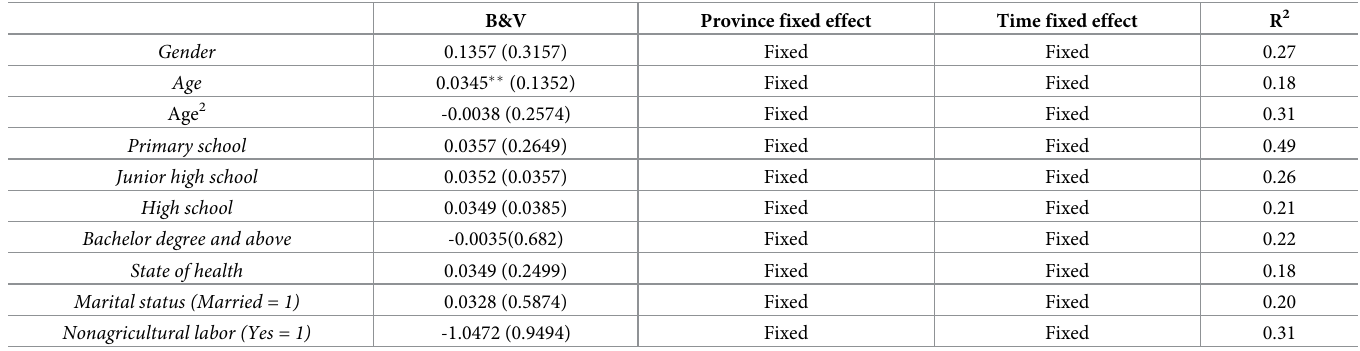
Table 3. Model validity test